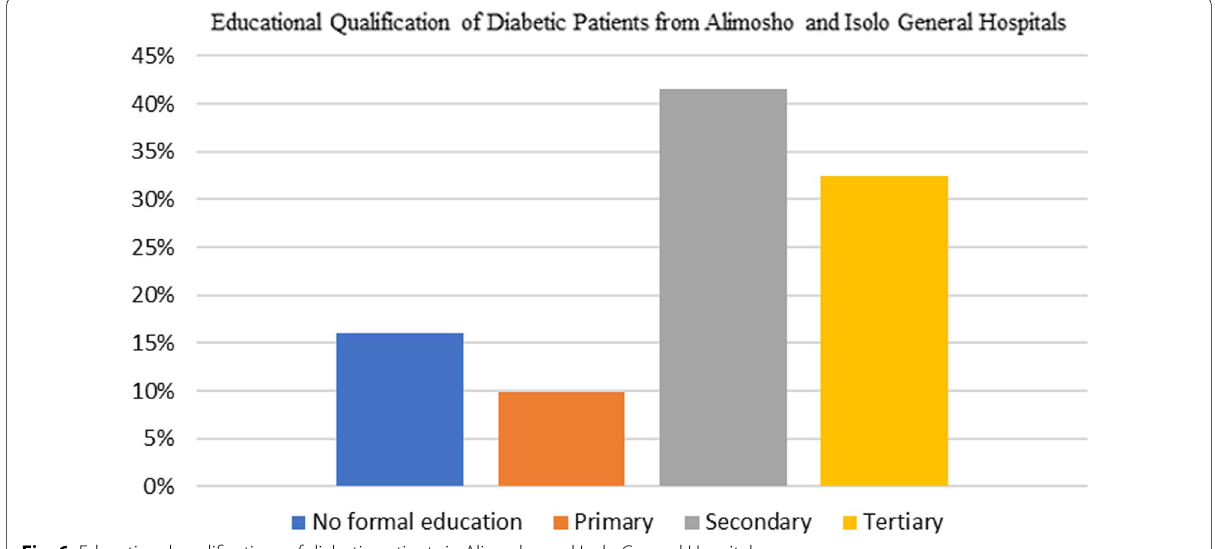
Fig. 6 Educational qualifications of diabetic patients in Alimosho and Isolo General Hospitals